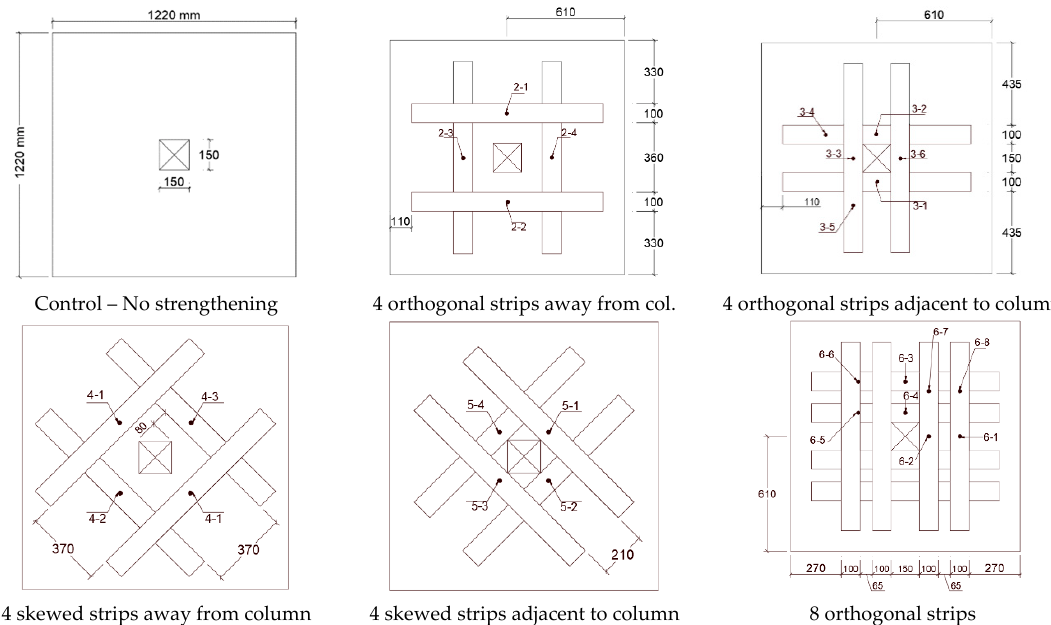
Figure 18. Effect of CFRP strip area, orientation with respect to column, and distance from face of column [39].